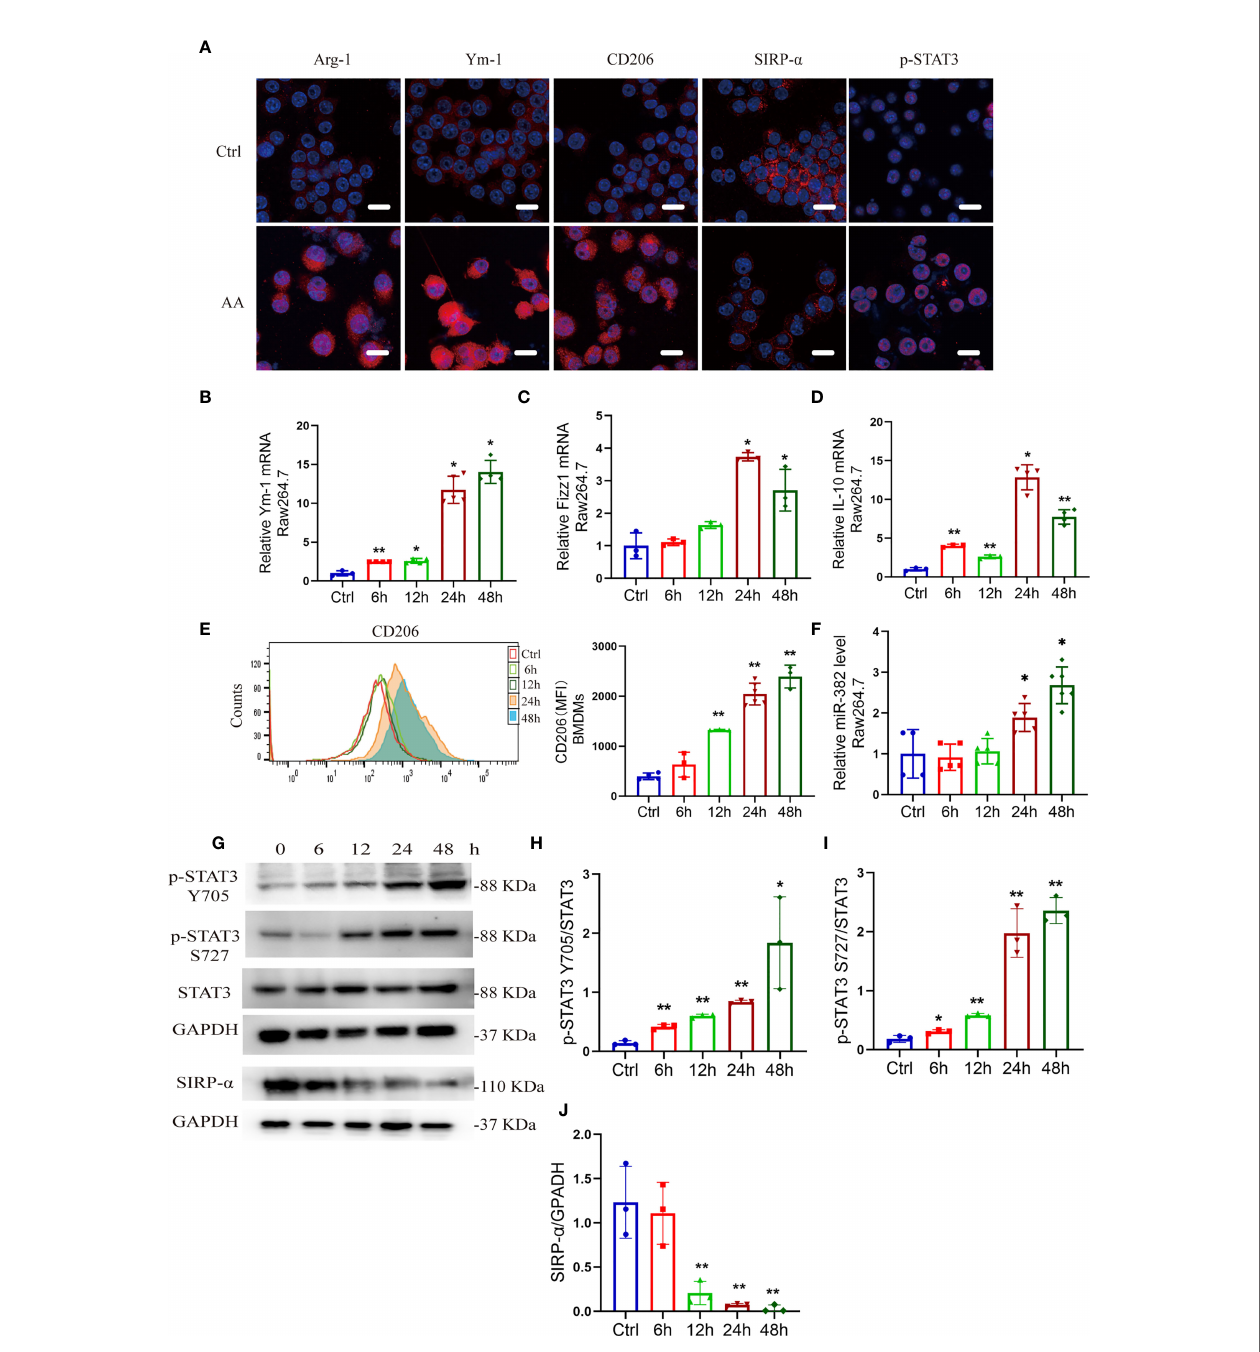
FIGURE 5 | AA induces M2-like macrophage polarization, accompanied by upregulation of miR-382 and phosphorylated STAT3 and downregulation of SIRP- a . (A) Immuno fl uorescence staining for Arg-1, Ym-1, CD206, SIRP- a , and p-STAT3 in Raw264.7 cells with NC or AA (10 m g/ml 48 h) induction. Scale bars, 20 m m. (B – D) mRNA levels of Ym-1, Fizz1, and IL-10 in Raw264.7 cells following AA treatment. 18S was used as an endogenous control. (E) Flow cytometry of CD206 + macrophages among bone marrow-derived macrophages (BMDMs) in the time course of AA treatment. (F) Levels of miR-382 in Raw264.7 cells in the time course; saline was administered as control treatment. U6 was used as an endogenous control. (G) Images of Western blot for p-STAT3 Y705, p-STAT3 S727, STAT3, and SIRP- a in Raw264.7 after treating AA 6, 12, 24, and 48 h. GAPDH served as standard. n = 3 holes each group. (H – J) Quanti fi cation of p-STAT3 Y705 and